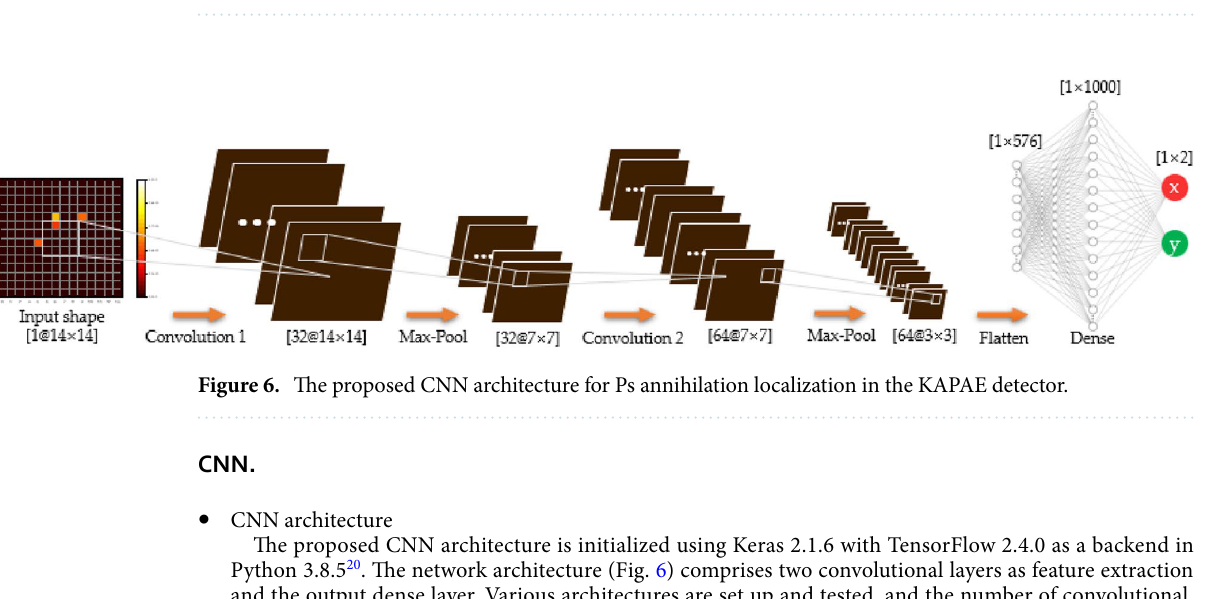
Table 3. The number of events corresponding to the energy cutoff ranges.